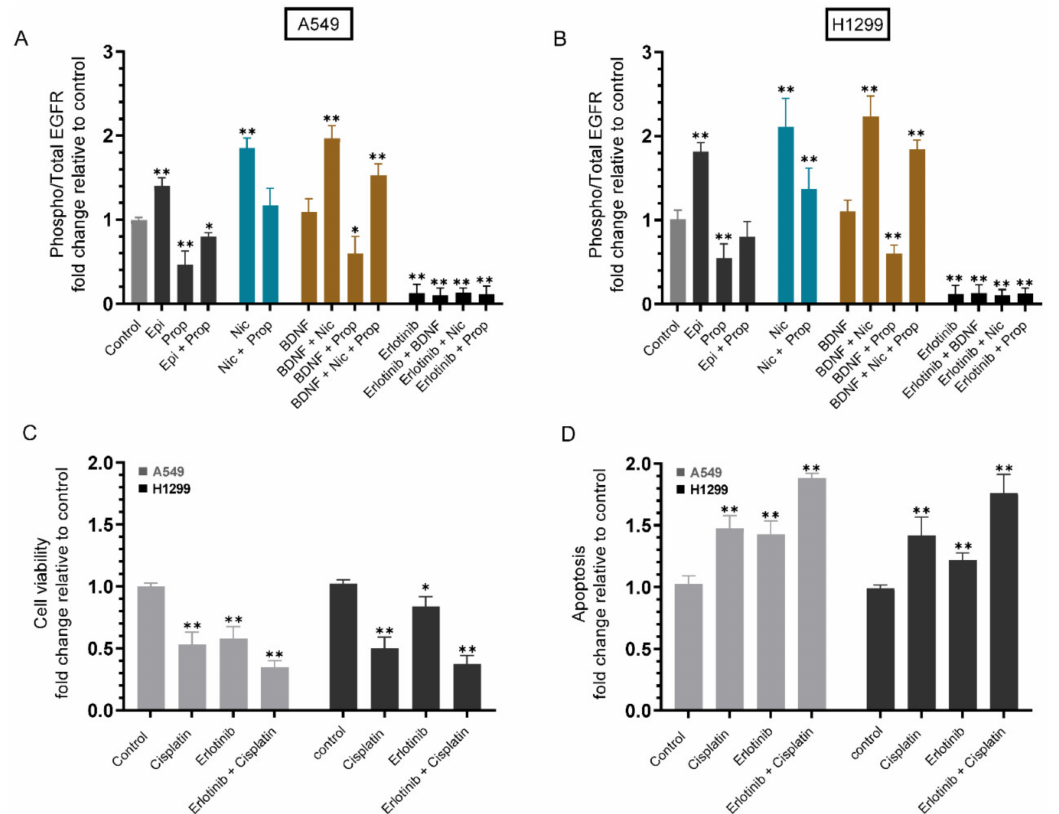
Figure 3. Phospho/Total EGFR ratio increased by cell treatment with epinephrine or nicotine and decreased by propranolol, while blocking EGFR activation by erlotinib increased cell sensitivity to cisplatin. Cells (0.2 × 10 5 ) were grown in 10% FBS-supplemented media for 24 h. The following day, the cell monolayers were serum starved for 24 h, then incubated in serum-free media for 72 h in the presence of epinephrine (Epi, 100 nM), propranolol (Prop, 1 µ M), nicotine (Nic, 1 µ M), BDNF (5 nM), erlotinib (10 µ M), or in combination. The phospho/total EGFR assay ( A , B ) was carried out as described in the Methods section. Cell viability ( C ) and apoptosis ( D ) were determined in the presence of erlotinib (10 µ M) without or with 10 µ M cisplatin, when using A549 cells, and 30 µ M cisplatin, when using H1299 cells, as described in the Methods section. Data from five independent assays, each carried out in triplicate, were averaged, normalized, and expressed as fold change relative to control untreated cells (Control) using the GraphPad 9.4.1 software. The graphs summarize the results expressed as means ± SD (n = 5). Asterisks (*) indicate a statistically significant difference from the corresponding control for each cell line, Mann–Whitney test, while the absence of asterisks indicates no significance. * p < 0.05, ** p <